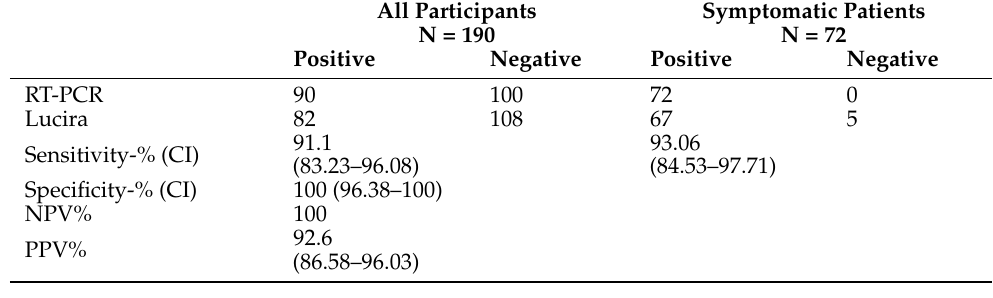
Table 1. Comparison of SARS-CoV-2 detection between RT-PCR and Lucira in symptomatic patients and all participants.